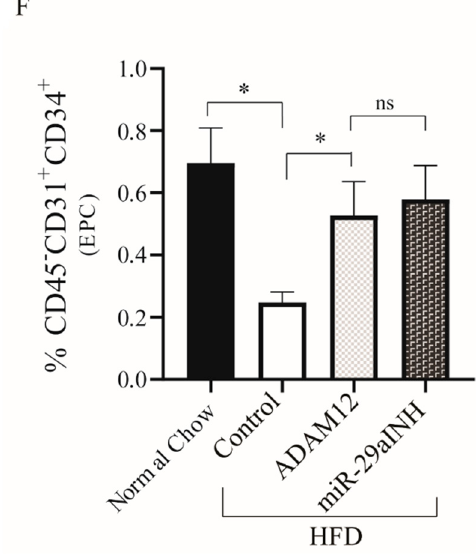
Figure 5. ADAM12 gene transfer and miR-29a inhibition rescued impaired endothelial progenitor cells recruitment in post-ischemic GA muscle of HFD mice. Cells were isolated from day 7 post- ischemic mouse GA muscle from normal chow, HFD, HFD + ADAM12, and HFD + miR-29aINH treated animals and analyzed with flow cytometry. Endothelial progenitor cells were defined as CD45 - CD31 + CD34 + cells. ( A – E ) : Representative gating of flowcytometric analysis of the EPCs. F: Quantification of the percentage of EPCs in ischemic hind limb of the groups of animals studied (* p < 0.05 and Normal Chow: n = 4, HFD Control: n = 5, HFD + ADAM12: n = 4 and HFD + miR29aINH: n = 5).